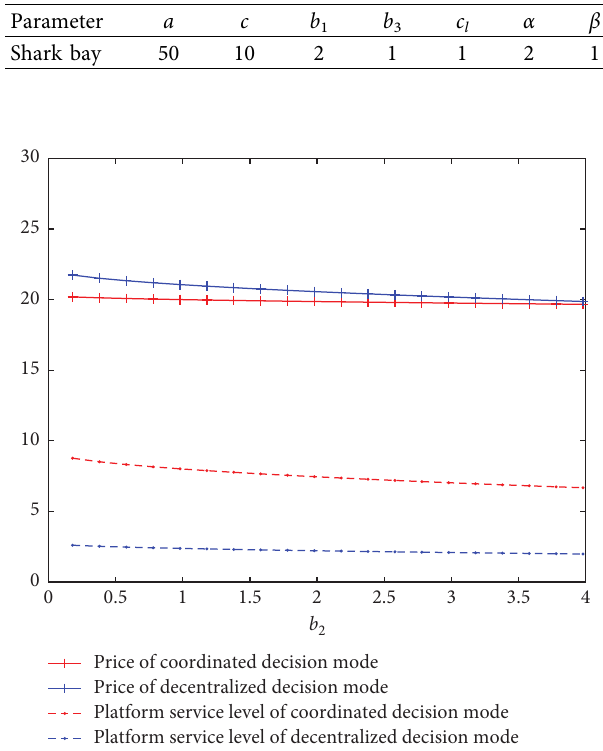
Figure 2: The price and platform service level of the coordinated mode and decentralized mode supply chain.